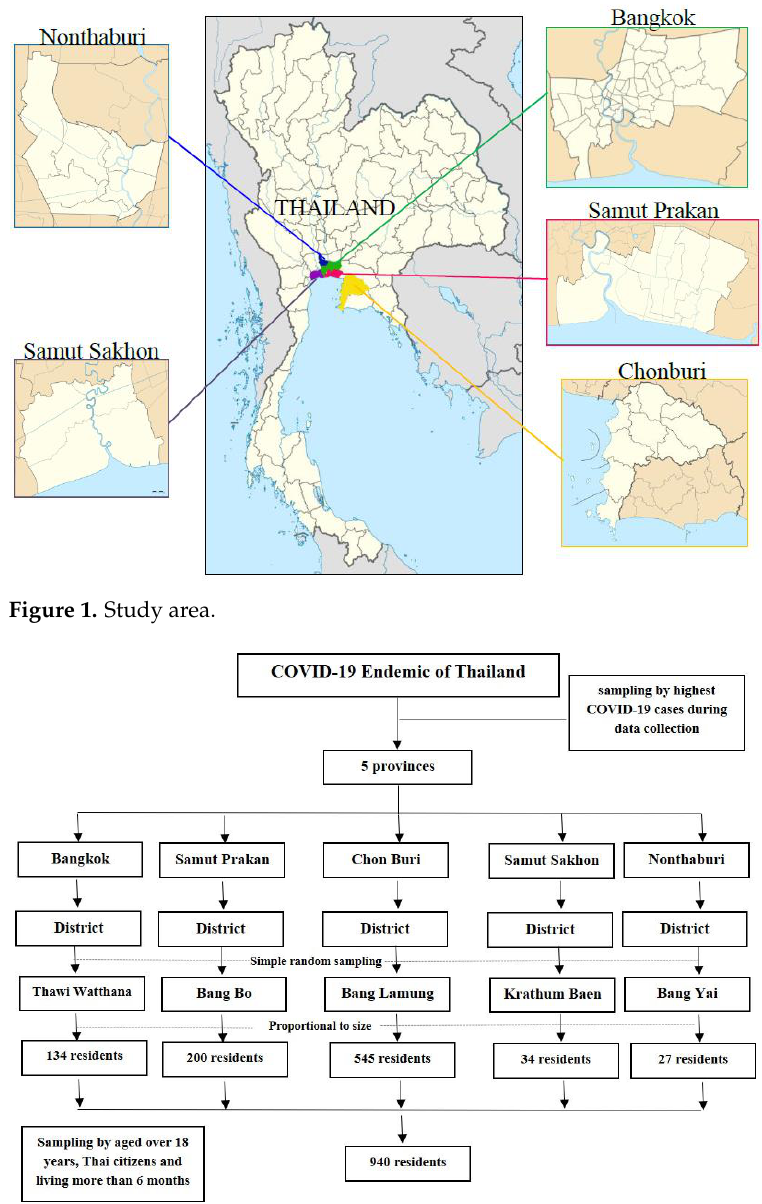
Figure 2. Procedures for sampling frame of resident samples .